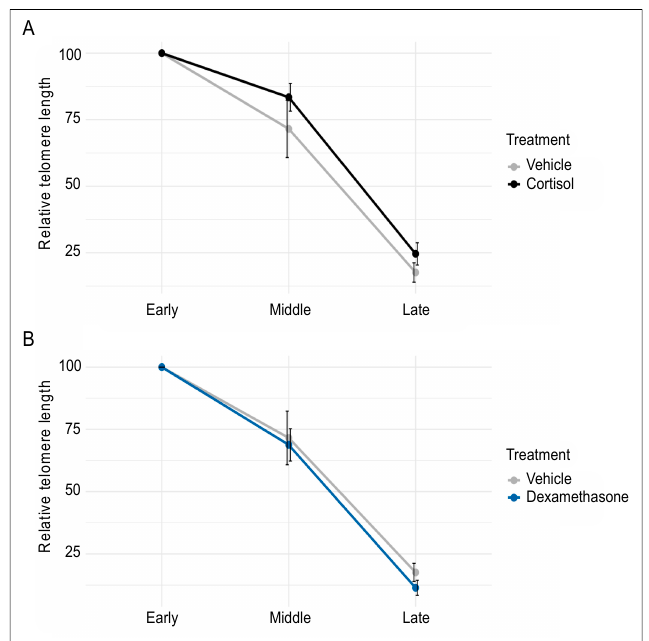
Figure 1. Prolonged glucocorticoid exposure to 100 nM of either cortisol or dexamethasone induces robust and cumulative gene induction as indicated by mRNA levels of the known glucocorticoid-responsive gene FKBP5 . Each time point included 6 biological replicates for the vehicle and cortisol group and 3 biological replicates for the dexamethasone group. For each time point, mRNA levels were normalized and are shown as fold change compared to vehicle control. Error bars represent one standard error above and below the mean.